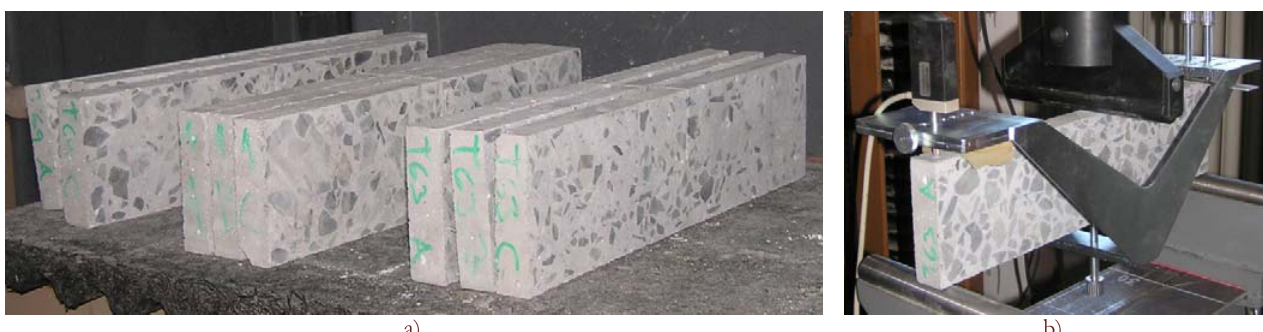
Figure 1: a) Preparation of notched specimens for bending test from standard beams, b) employed fracture test geometry – three-point bending of notched beam – with a depiction of the measuring fixture enabling recording of pure beam deflection.